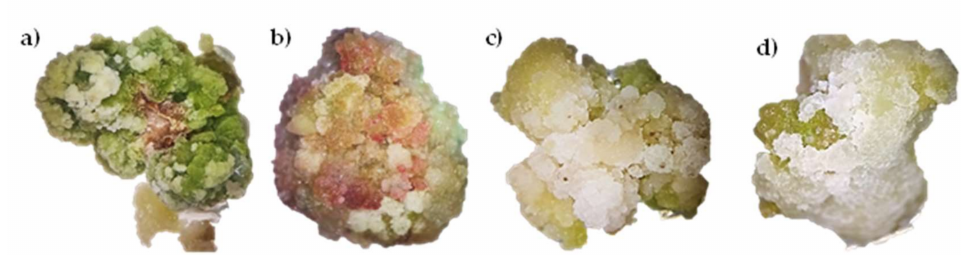
Figure 2. Callus obtained from tempisque explants after 40 days of incubation, ( a ) callus obtained from leaf with 1 mg/L of 2,4-D and 1 mg/L of TDZ, ( b ) callus obtained from leaf with 0.5 mg/L of 2,4-D and 1 mg/L of TDZ, ( c ) callus obtained from stem with 1 mg/L of 2,4-D and 1 mg/L of TDZ, ( d ) callus obtained from stem with 0.5 mg/L of 2,4-D and 1 mg/L of